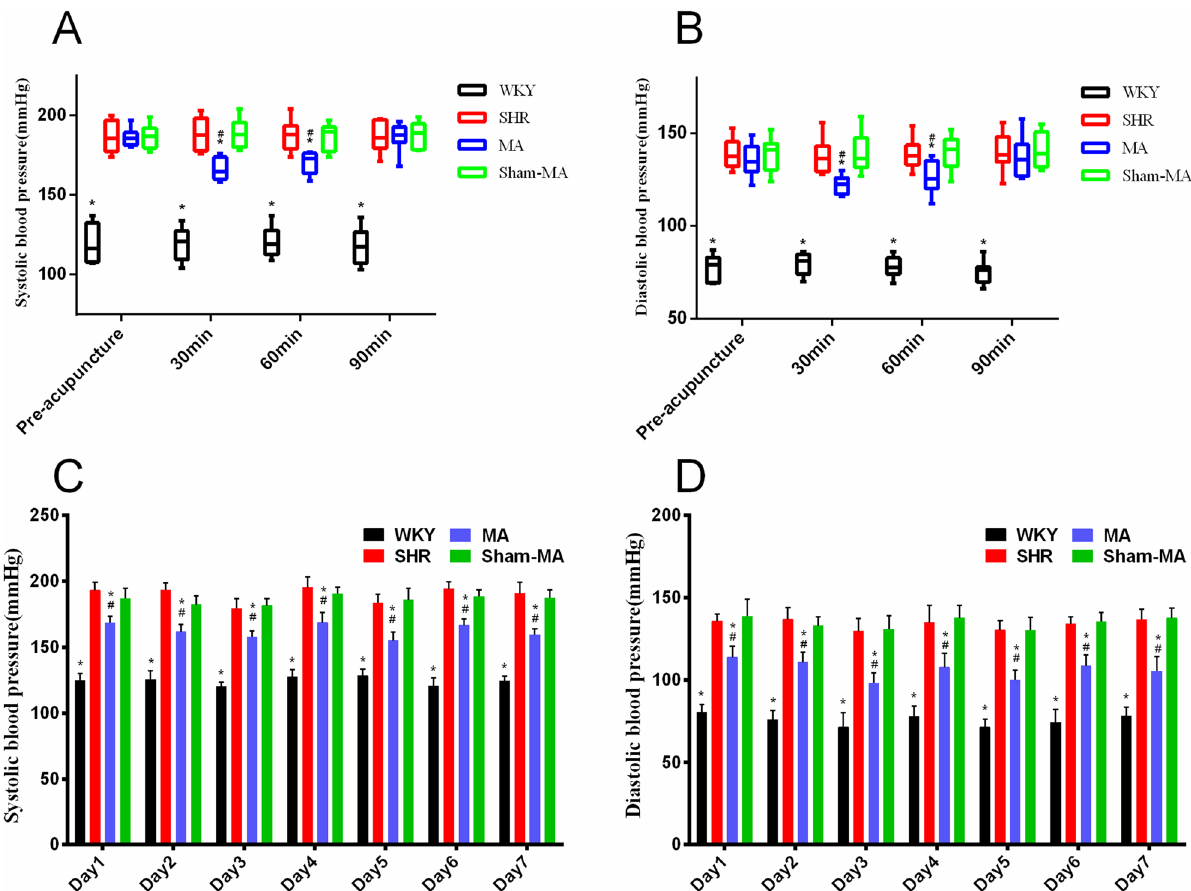
Figure 1. Reducing blood pressure (BP) effects induced by MA in SHRs. Differences in systolic blood pressure (SBP) ( A ) (H (Pre-acupuncture) = 17.48, H (30 min) = 25.68, H (60 min) = 24.15, H (90 min) = 17.48, Kruskal–Wallis Test) and ( C ) (F (Day1) = 102.21, F (Day2) = 101.11, F (Day3) = 100.12, F (Day4) = 103.36, F (Day5) = 102.56, F (Day6) = 108.47, F (Day7) = 100.04, repeated measurement ANOVA) and diastolic blood pressure (DBP) ( B ) (H (Pre-acupuncture) = 17.79, H (30 min) = 25.32, H (60 min) = 21.78, H (90 min) = 18.12, Kruskal–Wallis Test) and ( D ) (F (Day1) = 96.62, F (Day2) = 97.40, F (Day3) = 94.67, F (Day4) = 95.72, F (Day5) = 94.99, F (Day6) = 98.54, F (Day7) = 93.61, repeated measurement ANOVA) among WKY, SHR, MA and Sham-MA groups were detected at 30, 60 and 90 min after the first day of treatment, or every day of the 7-day treatment. *p < 0.05 versus the SHR group, # p < 0.05 versus the Sham-MA